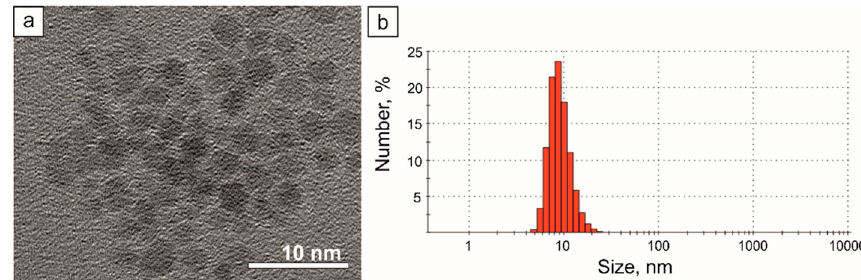
Figure 1. Characterization of synthesized magnetite nanoparticles: ( a ) TEM image and ( b ) size distribution, measured by dynamic light scattering.